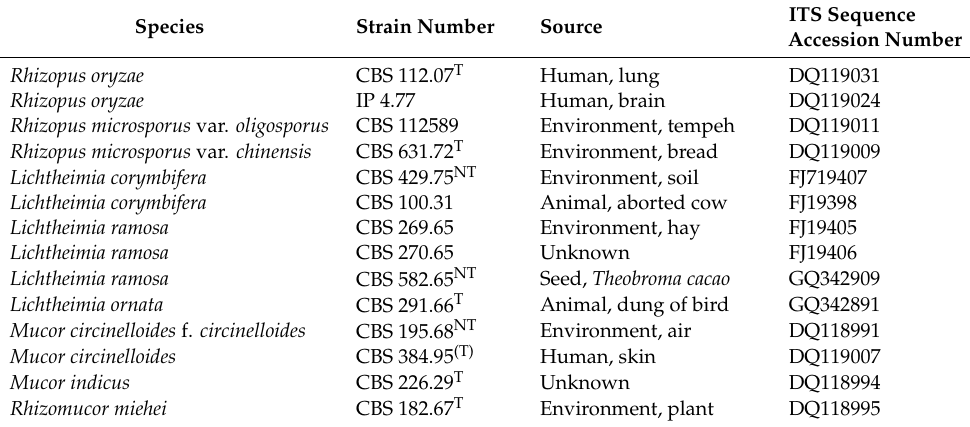
Table 1. List of isolates used for the construction of the